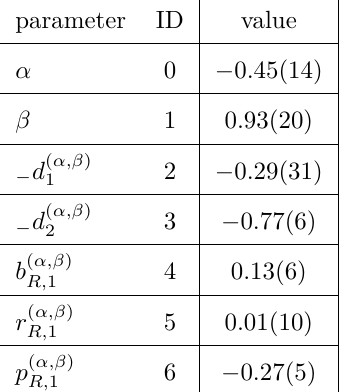
Figure 8 . The results of fitting to the model “default”. The upper and lower plots come from the fits to the real and imaginary components respectively. The PDFs are given on the left and on the right, the nuisance terms are compared to the ITD, reduced pseudo-ITD, and the leading twist part of the reduced pseudo-ITD. For the reduced pseudo-ITD, the value z = 4 ∗ 0 . 0652 fm was used as a typical example.